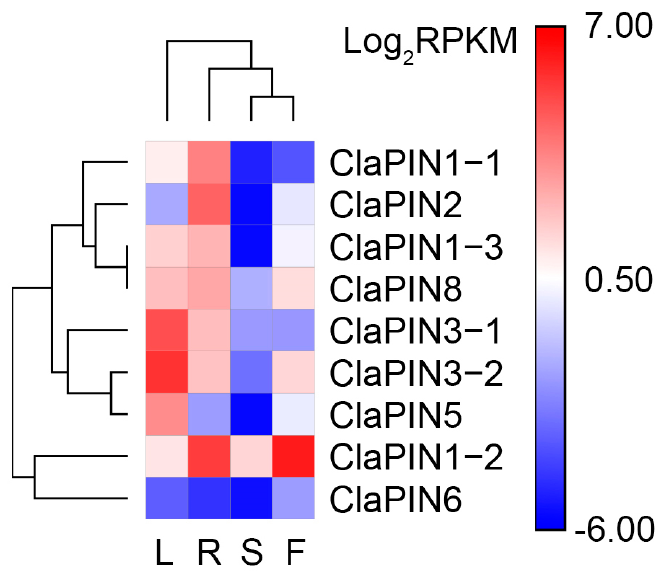
Figure 2. Cis -elements ( A ) and intron ( B ) structures of watermelon PIN family. The cis -element prediction was conducted with 2000 bp upstream sequences by the PlantCARE software [41]. The intron structure analysis was conducted with genomic and coding sequences of watermelon PIN family.